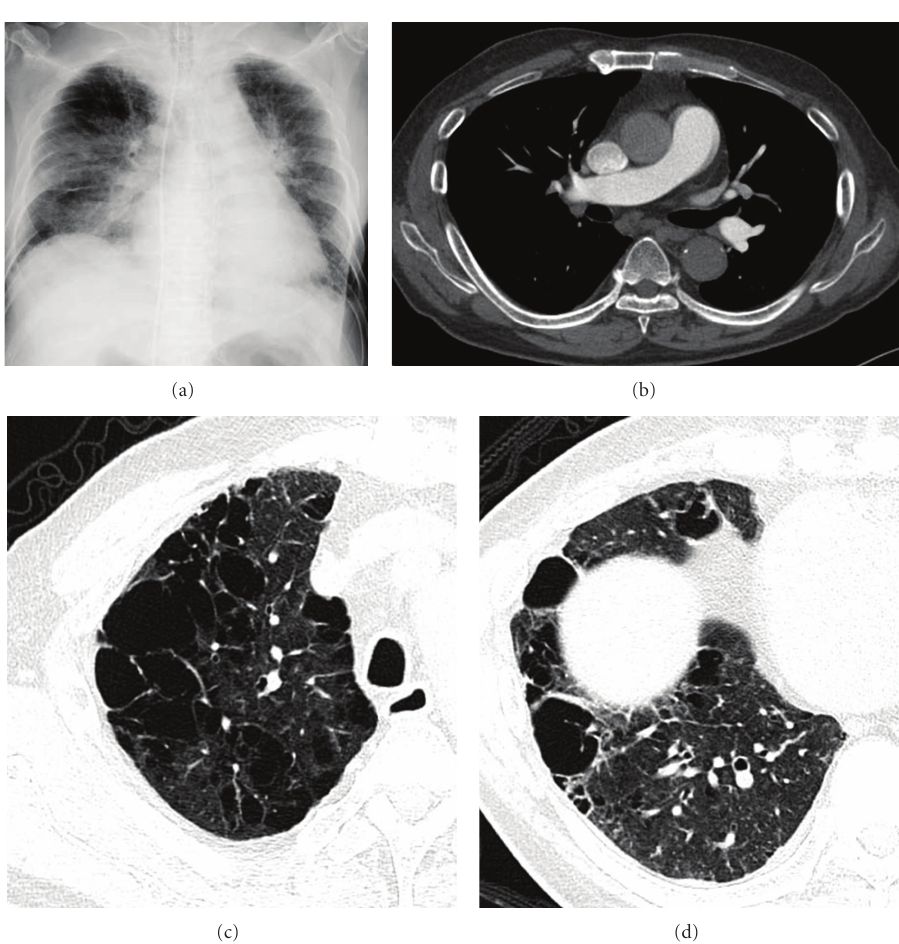
Figure 6: Emphysema with fibrosis, pulmonary hypertension. Estimated right ventricular pressure by cardiac ultrasound is 80mmHg. (a) Chest X-ray shows cardiomegaly with enlargement of central pulmonary arteries. (b) Contrast-enhanced CT shows dilatation of central pulmonary arteries. There is no evidence of pulmonary thromboembolism. (c) High-resolution computed tomography (HRCT) of upper lung shows severe pulmonary emphysema; some cystic lesions have thick wall. (d) HRCT of the lower lung shows marked destructive change in the lung. There are several large cysts with thick